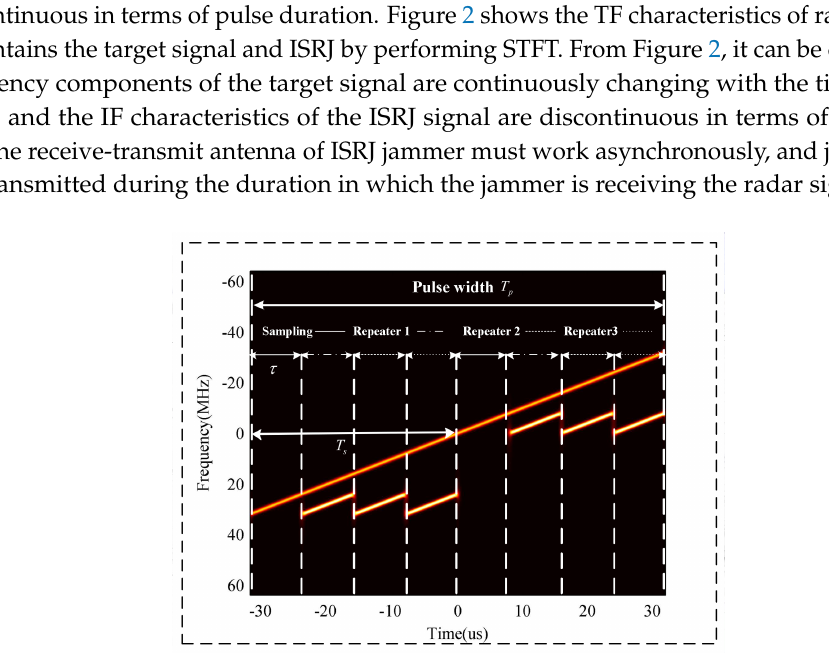
Figure 2. TF characteristics of LMF echo